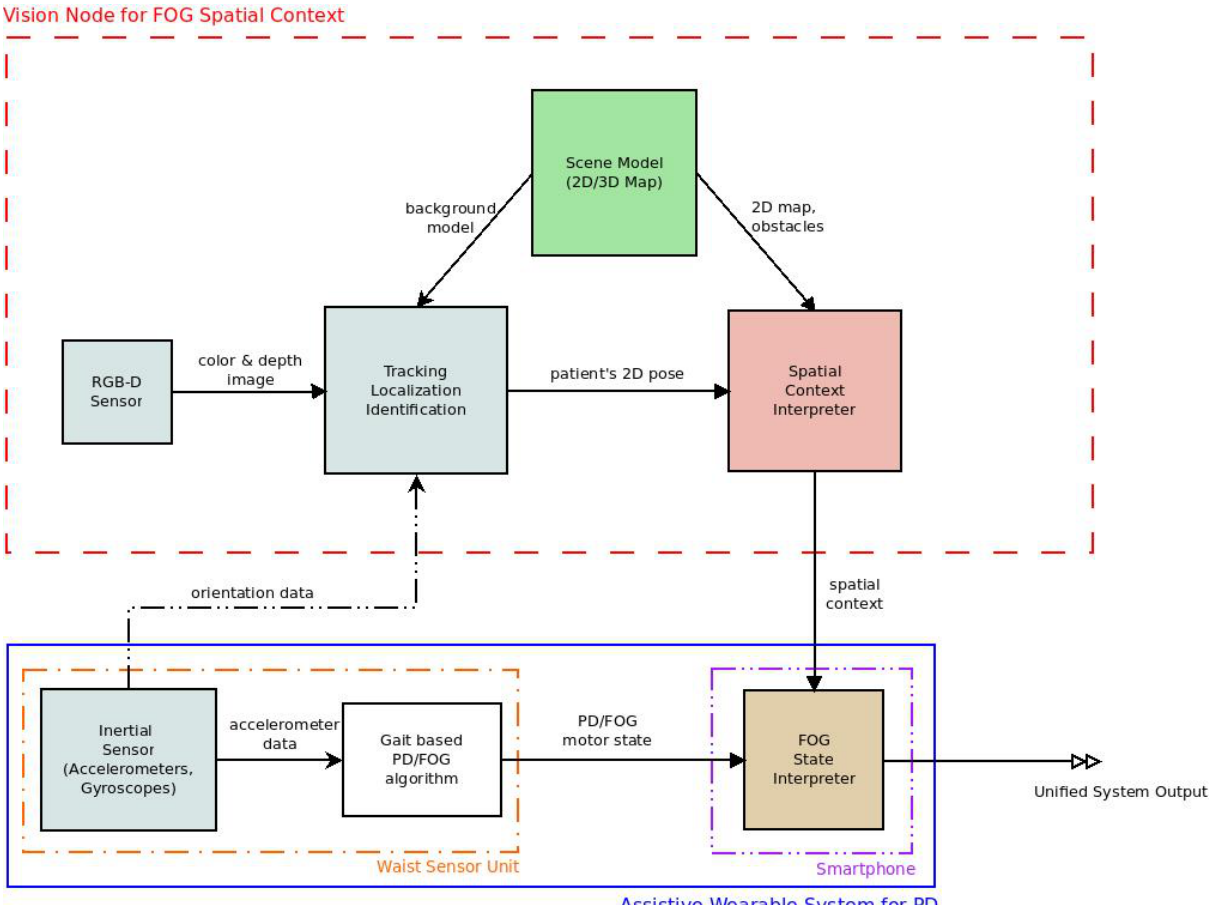
Figure 1. Block diagram for the concept of the ubiquitous monitoring system. The wearable system independently detects FoG based on inertial data (blue rectangle). Gait-based detection is complemented by the user's spatial context from the vision sensor system (red rectangle) in the areas of the home where such a system is